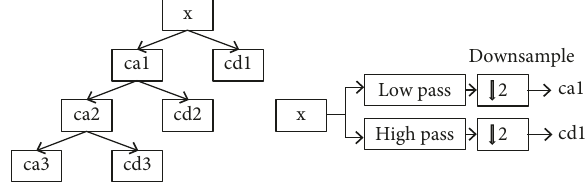
Figure 3: A three-level wavelet decomposition of a signal.